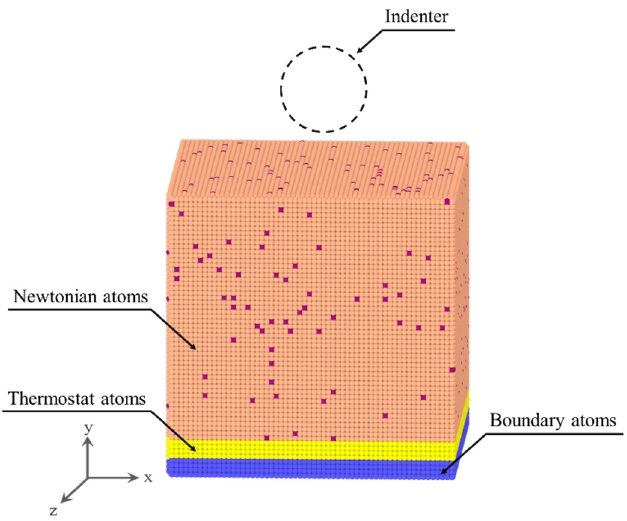
Figure 1. Three-dimensional MD model of Nb-Zr alloy for nanoindentation with Zr atoms colored purple.